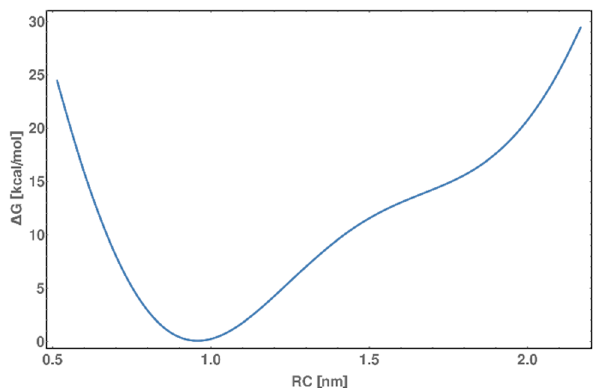
Figure 12. ( A ) Circular dichroism melting profiles (recorded at 220 nm) of dsDNA*-PEP over a 0–90 ◦ C temperature range. ( B ) Circular dichroism melting profiles (recorded at 220 nm) of dsDNA*-PEP over a 0–90 ◦ C temperature range. Heating (orange and blue curves) and cooling (red and cyan curves) experiments are shown. Curves represent the moving average of respective color dots (real measurement). Far-UV CD was measured on a Jasco J-810 spectropolarimeter (Jasco, Tokyo, Japan). Di ff erent measurements (for both heating and cooling) were conducted at a 1 ◦ C / min heating / cooling rate from 0 to 90 ◦ C or 90 to 0 ◦ C and normalized against TBA bu ff er.